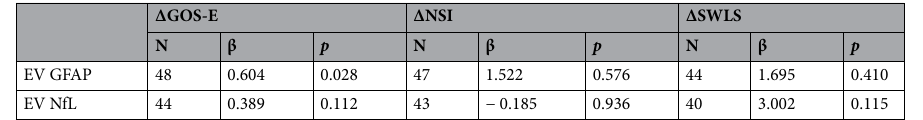
Table 3. Generalized linear model of change in outcome scores and biomarker concentrations, controlling for age and sex. GOS-E Glasgow Outcome Scale-Extended, NSI Neurobehavioral Symptom Inventory,